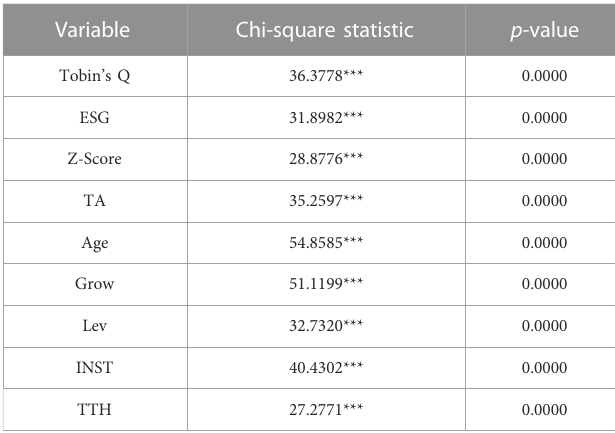
TABLE 3 Autocorrelation and heteroscedasticity test. TABLE 4 Stability